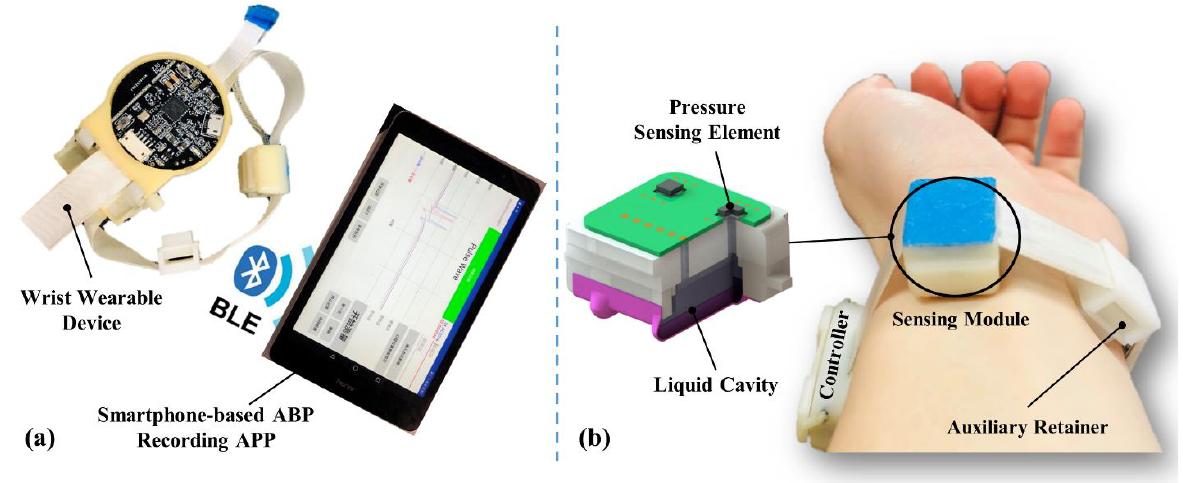
Figure 1. The radial artery BP measurement device: ( a ) BP measurement device and smartphone-based recording APP; ( b ) photo of the device worn on the wrist.